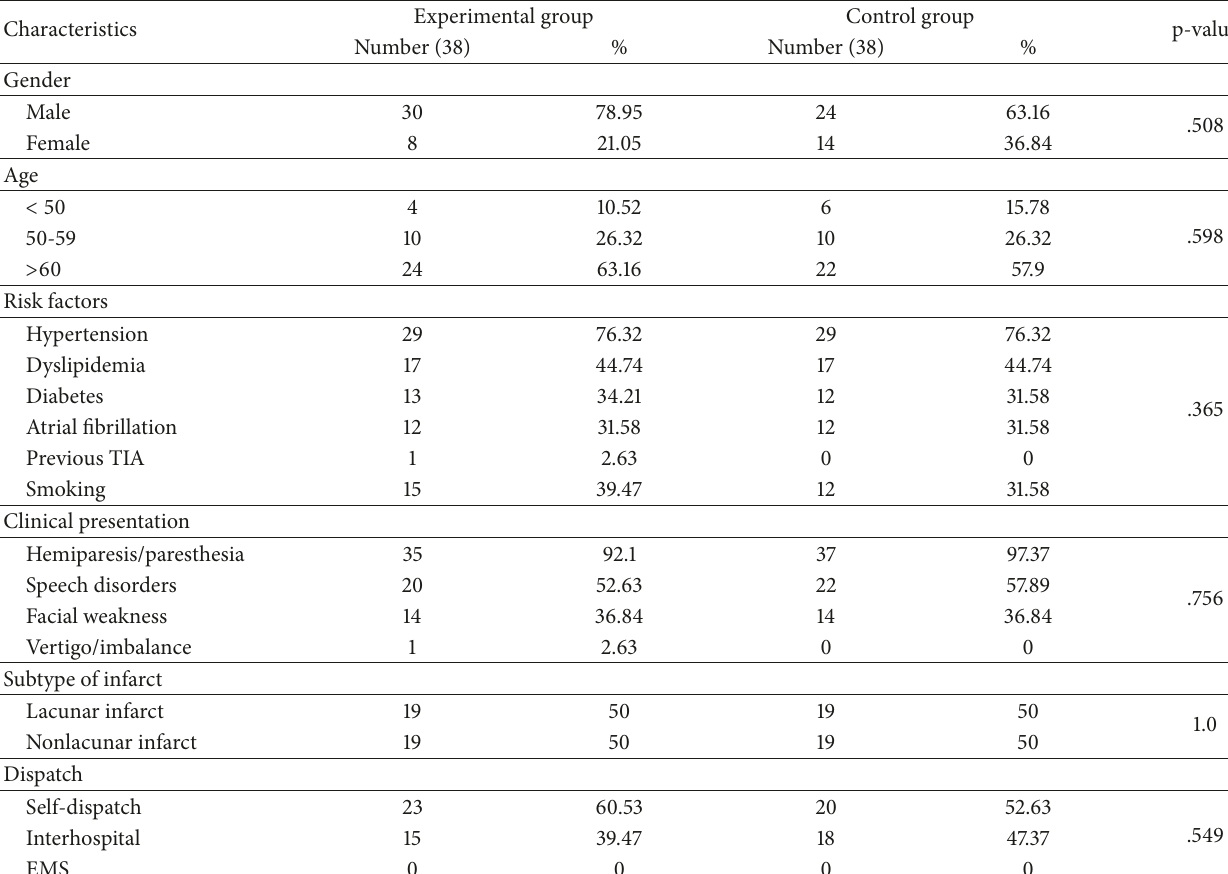
Table 2: Baseline